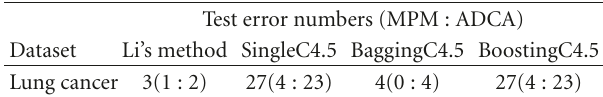
Table 4: Test error numbers of four models